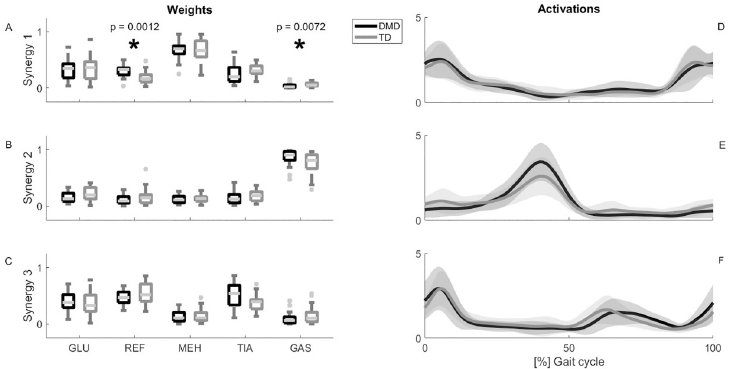
Fig 2. Results of SnPM {t} tests for the synergy activation curves and MWU tests for synergy weights ( α = 0.01). Panel A-C show the median + interquartile ranges of the weight of the GLU, REF, MEH, TIA and GAS to synergy one (A), two (B) and three (C) respectively. Significant differences between TD (grey) and DMD (black) based on the outcomes of MWU are indicated with an asterisk. Panel D–F show the mean values + standard deviations of the activations of synergy one (D), two (E) and three (F) respectively. Significant differences between TD (grey) and DMD (black) based on the outcomes of SnPM {t} are indicated as black bars. Abbreviations in alphabetic order: DMD = Duchenne muscular dystrophy; GAS = gastrocnemius; GLU = gluteus medius; MEH = medial hamstrings; MWU = Mann-Whitney U; REF = rectus femoris; SnPM {t}, statistical non-parametric mapping post-hoc two-tailed two-sampled t-test; TD = typically developing; TIA = tibialis